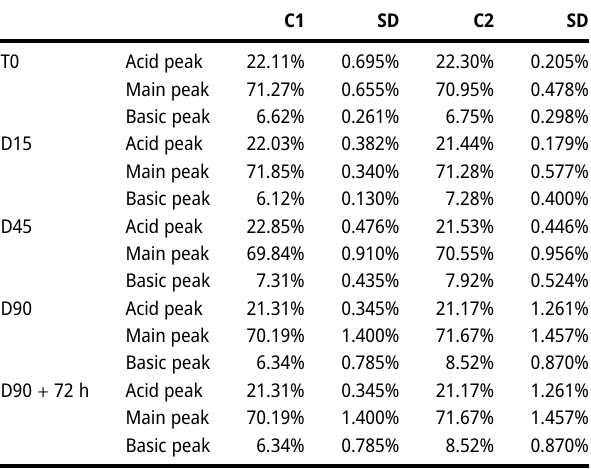
Table  : Relative % of isoforms of Bevacizumab demonstrated by ion exchange chromatography for bags following dilution to  .  mg/mL (C  ) and  .  mg/mL (C  ).